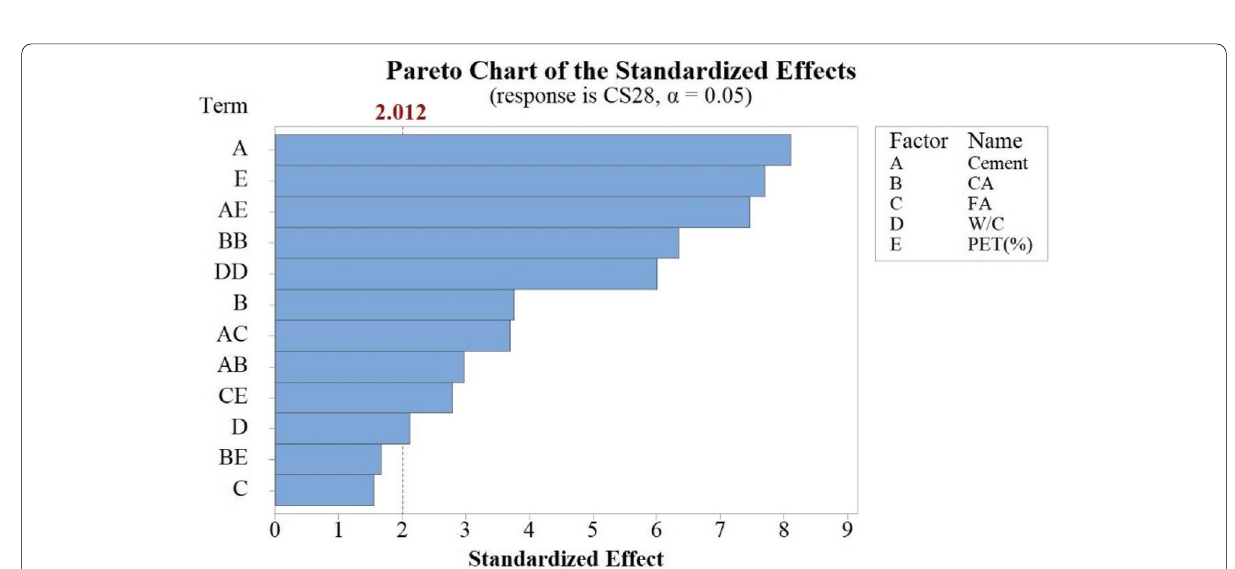
Fig. 5 Pareto Chart of PET-FA